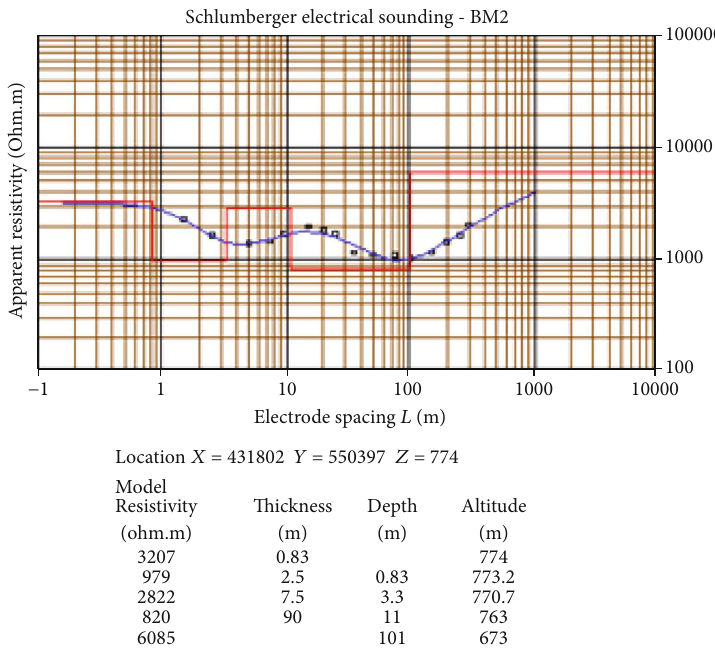
Figure 13: Sounding curve (BM